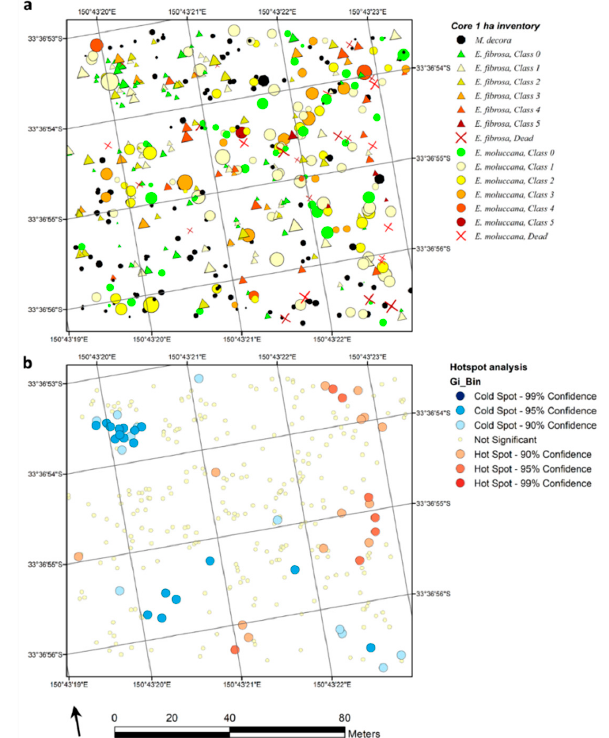
Figure 4. ( a ) Overview plot of the species and stage of infection of the core plot of 1 ha. The size of the symbols is linearly related to the DBH of the trees. ( b ) Indications of areas with significantly higher and lower mistletoe infection, respectively, following hot spot